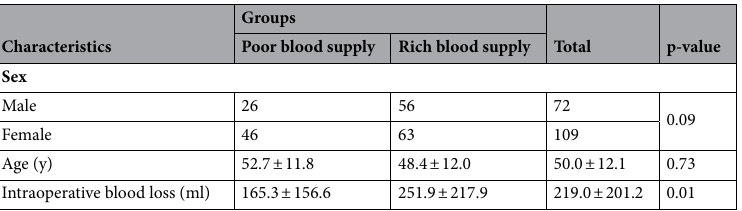
Table 1. Sex, age and intraoperative blood loss distribution between the poor blood supply group and the rich blood supply group. Mean ± standard deviation.